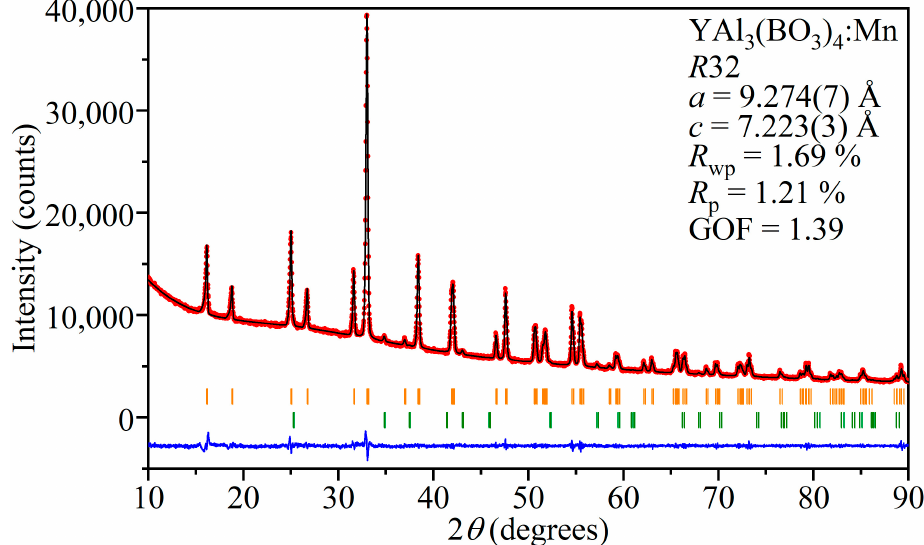
Figure 2. Final convergence of the Le Bail refinement for YAl 3 (BO 3 ) 4 :Mn. The experimental diffraction pattern is shown by red circles (I obs ); the black line (I calc ) is the calculated diffraction pattern and the residual intensities (I obs -I calc ) are shown as the blue line. The orange bars indicate the YAl 3 (BO 3 ) 4 reflections, and the green bars indicate the Al 2 O 3 reflections.